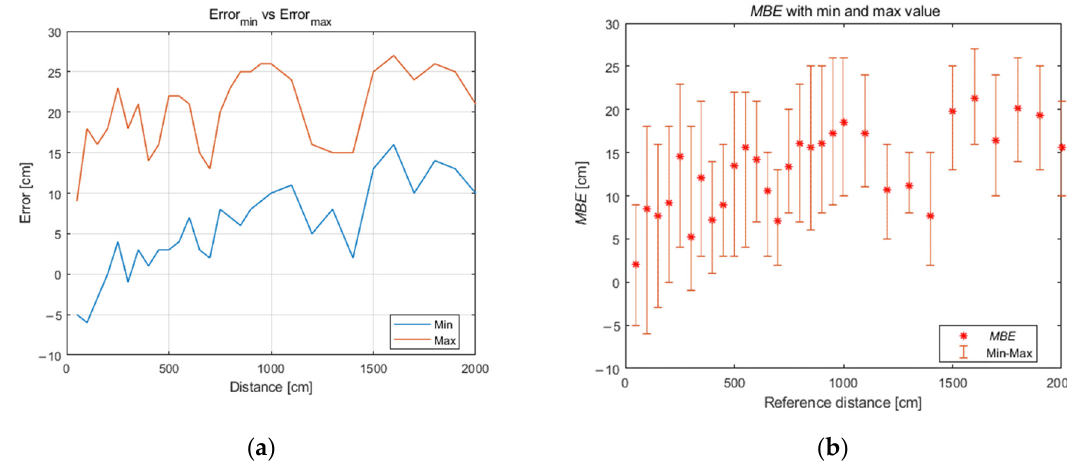
Figure 6. Distance error: ( a ) maximum and minimum value of error with distance; ( b ) range of distance error ( MBE ) for each reference distance.